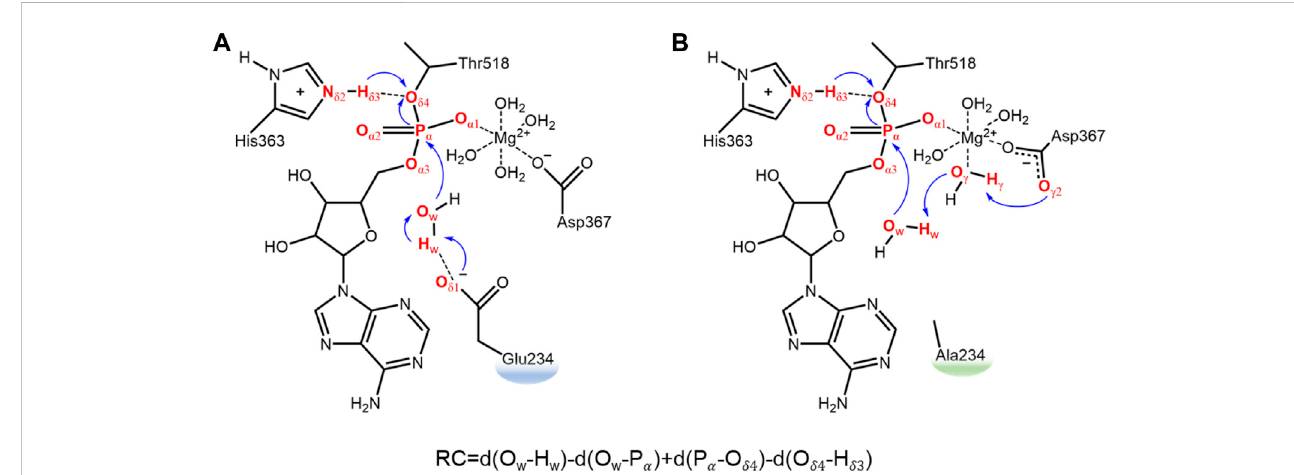
Schematic research model and de fi ned reaction coordinates for the deAMPylation process in the FICD wild type (A) and Glu234Ala mutant (B) . Electron transfer path of deAMPylation is labeled in blue arrows, and atoms involved directly in this process are colored in red.